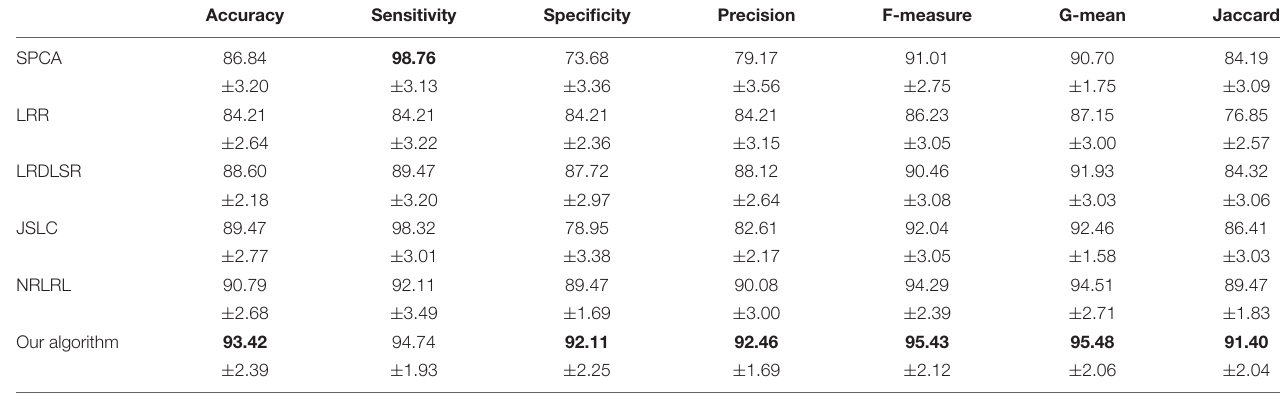
The bold values mean the best performance results.